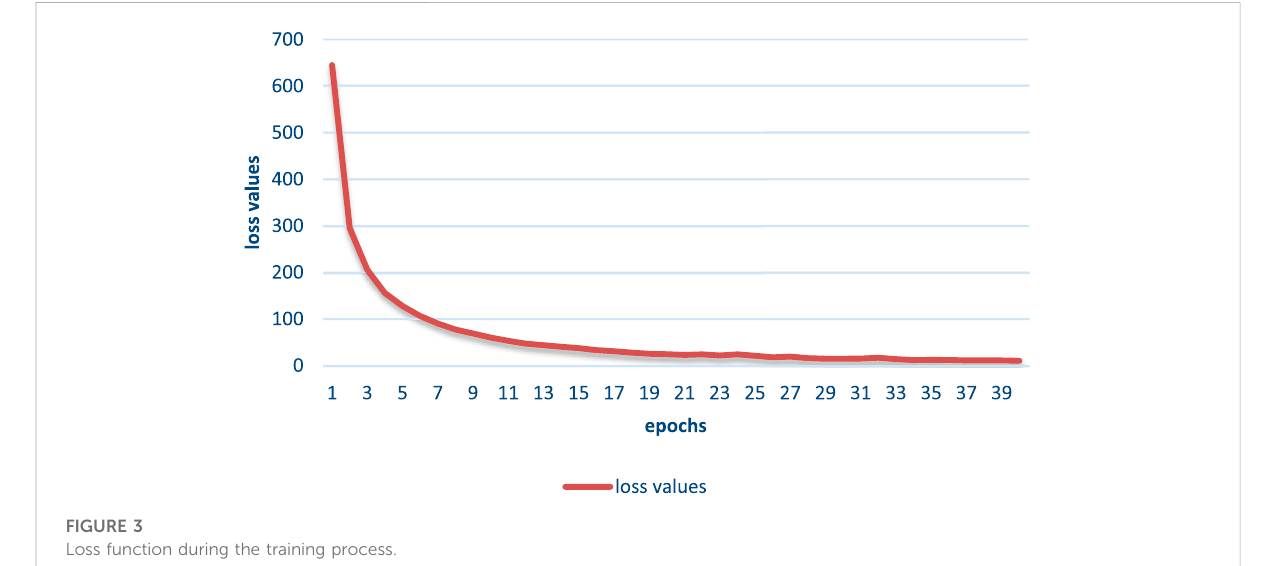
FIGURE 3 Loss function during the training